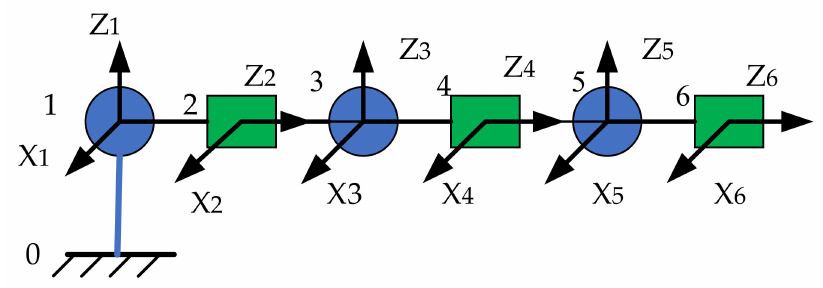
Figure 1. The structure of 6-DOF robotic manipulator. Table 1. D-H parameters of the 6-DOF robot. Link